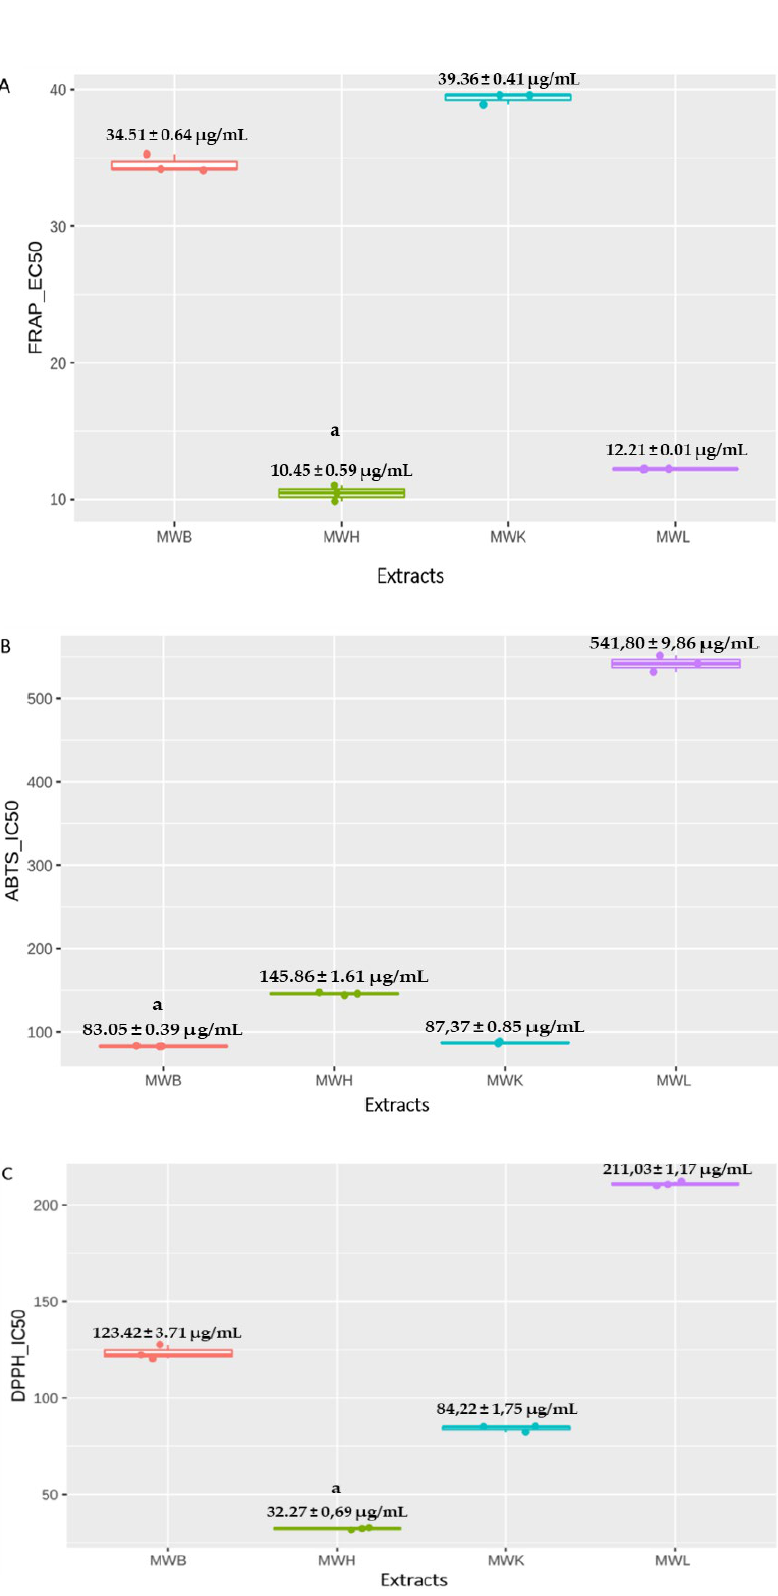
Figure 1. Boxplots showing FRAP ( A ), ABTS ( B ), and DPPH ( C ) radicals scavenging activities of J. regia methanolic extracts. a p < 0.05, Data expressed as mean ± SD. Abbreviations. MWB: Methanolic Extract of bark, MWH: Methanolic extract of Husk, MWK: Methanolic Extract of Kernels, MWL Methanolic Extract of Leaves.